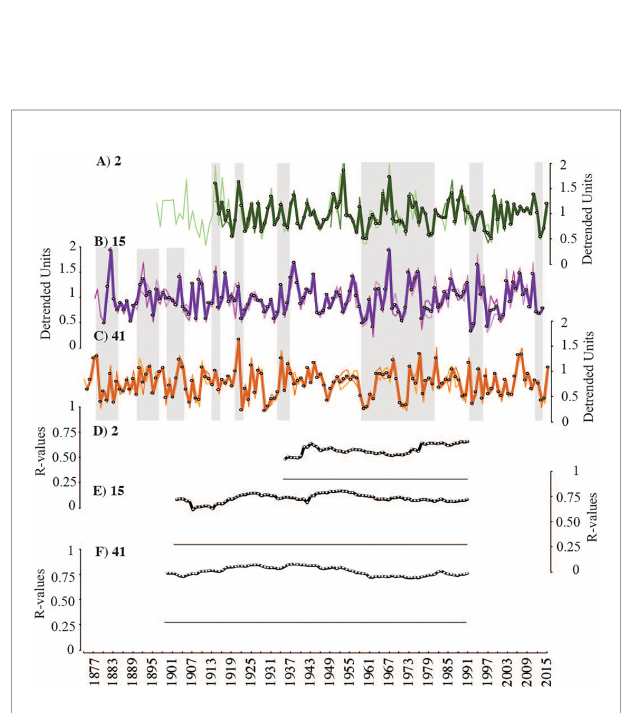
FIGURE 5 | All crossdated growth increment data presented as detrended growth timeseries (A – C) . Data from individual transects are plotted as thin lighter lines and sample averages as thicker darker lines. Intra-sample replicability presented as plotted R-values of running correlations (49-year windows) (D – F) . Flat black lines represent threshold of signi fi cance (p < 0.05). All samples have signi fi cant intra-sample correlations throughout timeseries lengths.